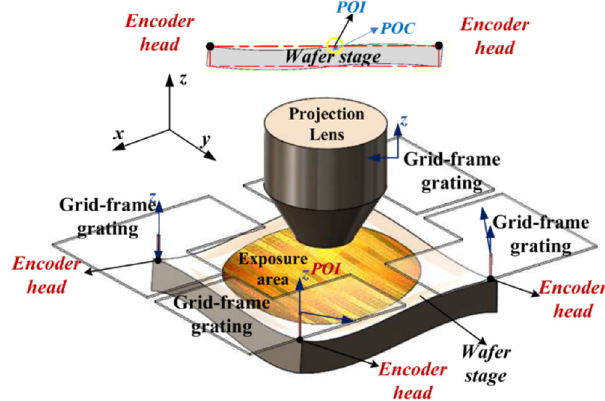
Fig. 1. POC and POI in the schematic of the fl exible